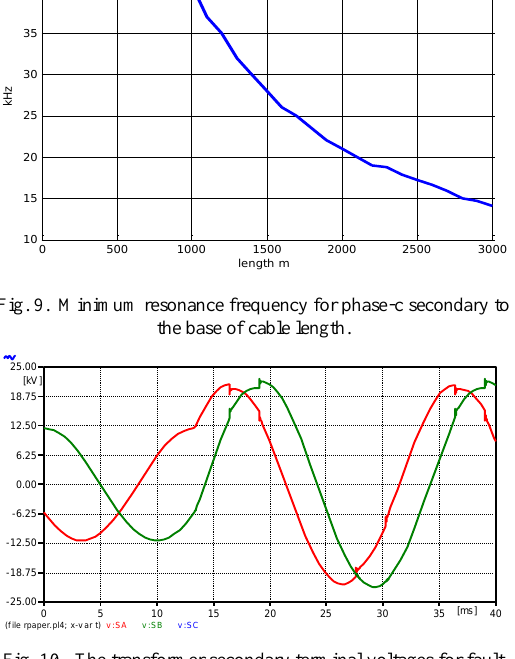
Fig. 10. The transformer secondary terminal voltages for fault inception angle 180  .